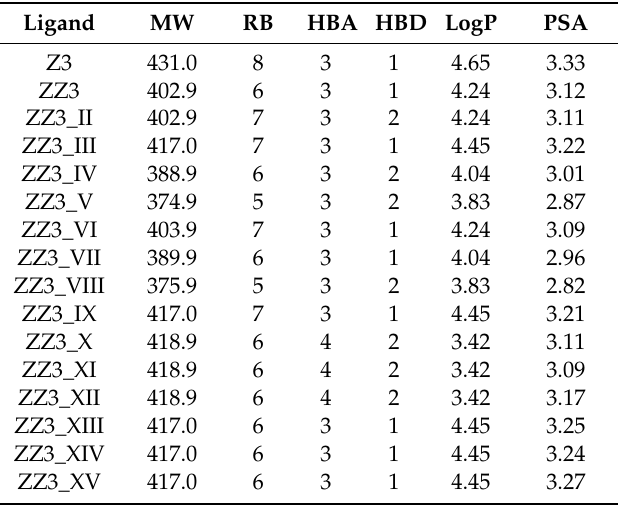
Table 1. Chemical properties of Z3, ZZ3 and its derivatives created by SwissBioisostere [16]; molecular weight (MW, Da), number of rotatable bonds (RB), number of H-bond acceptors (HBA), number of H-bond donors (HBD), octanol-water partition coe ffi cient (LogP), and polar surface area (PSA) evaluated by SwissADME